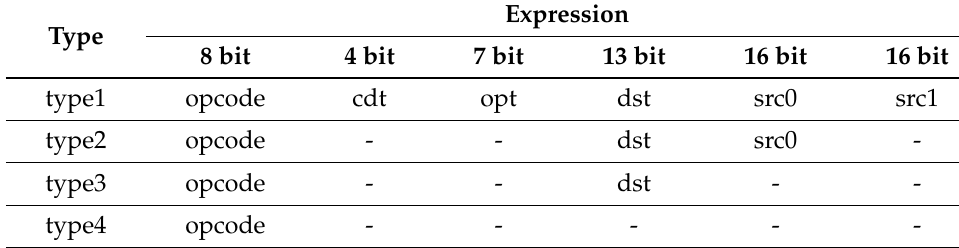
Table 4. Instruction